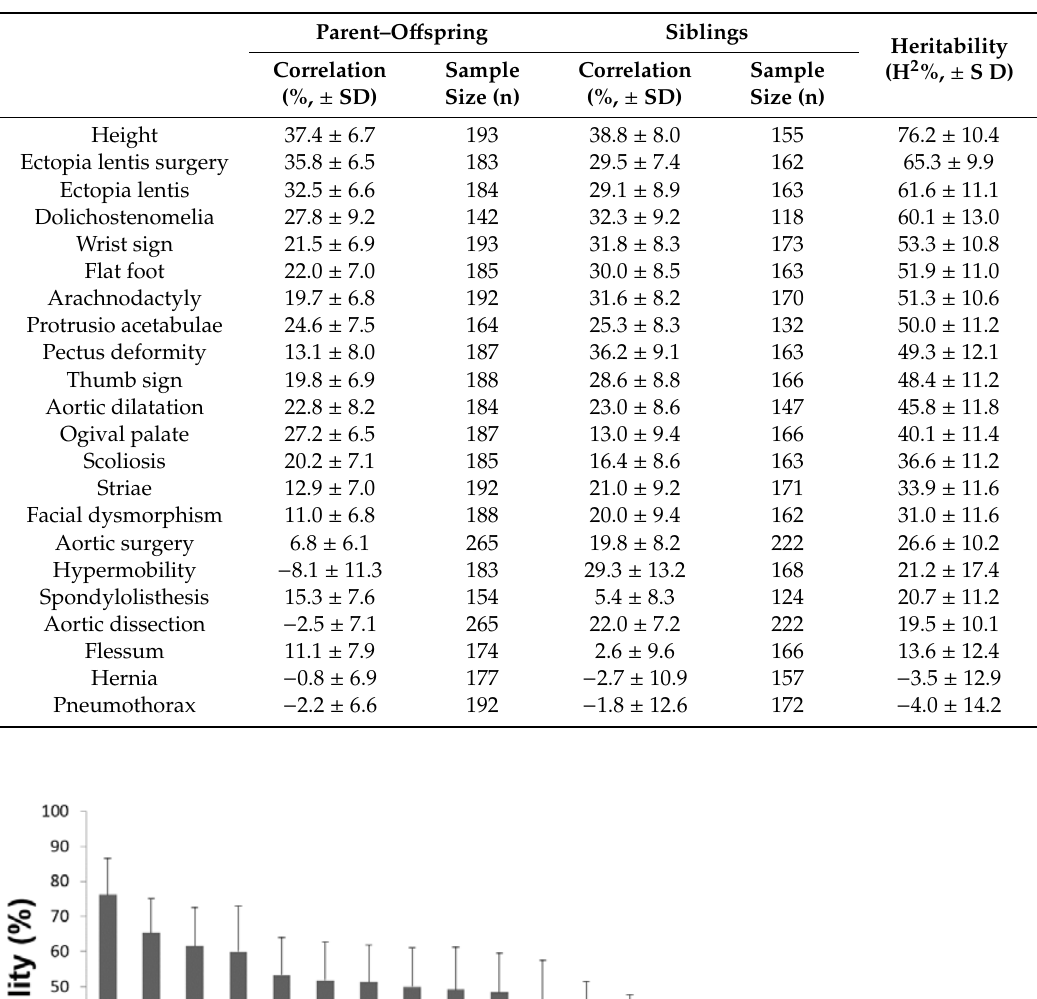
Table 1. Phenotypic correlations between first degree relatives and heritability estimates. Phenotypic correlations were computed on S.A.G.E (Statistical Analysis for Genetic Epidemiology) after correction for age and sex.